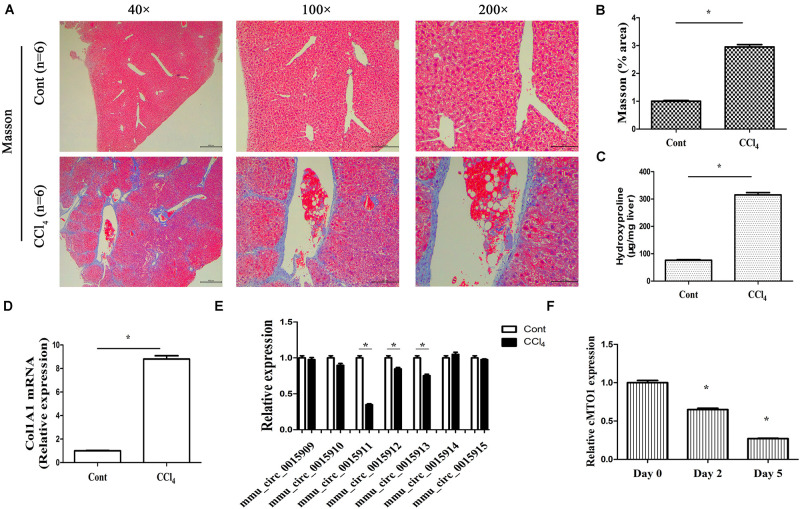
Expression of cMTO1 in CCl4-induced hepatic fibrotic tissues as well as primary HSCs. (A,B) Masson staining for assessing collagen deposition. Scale bar = 400 μm for 40×, 200 μm for 100× and 100 μm for 200×. The assessment of Masson area was finished at 100×. (C) Hydroxyproline level. (D) Col1A1 mRNA level. (E) circRNA splices derived from mouse MTO1 gene including mmu_circ_0015909, mmu_circ_0015910, mmu_circ_0015911, mmu_circ_0015912, mmu_circ_0015913, mmu_circ_0015914 and mmu_circ_0015915 were detected in CCl4 mice. (F) Expression of cMTO1 was analyzed in isolated primary HSCs at different culture time. *P < 0.05 compared to the control. Each value is the mean ± SD of three experiments.